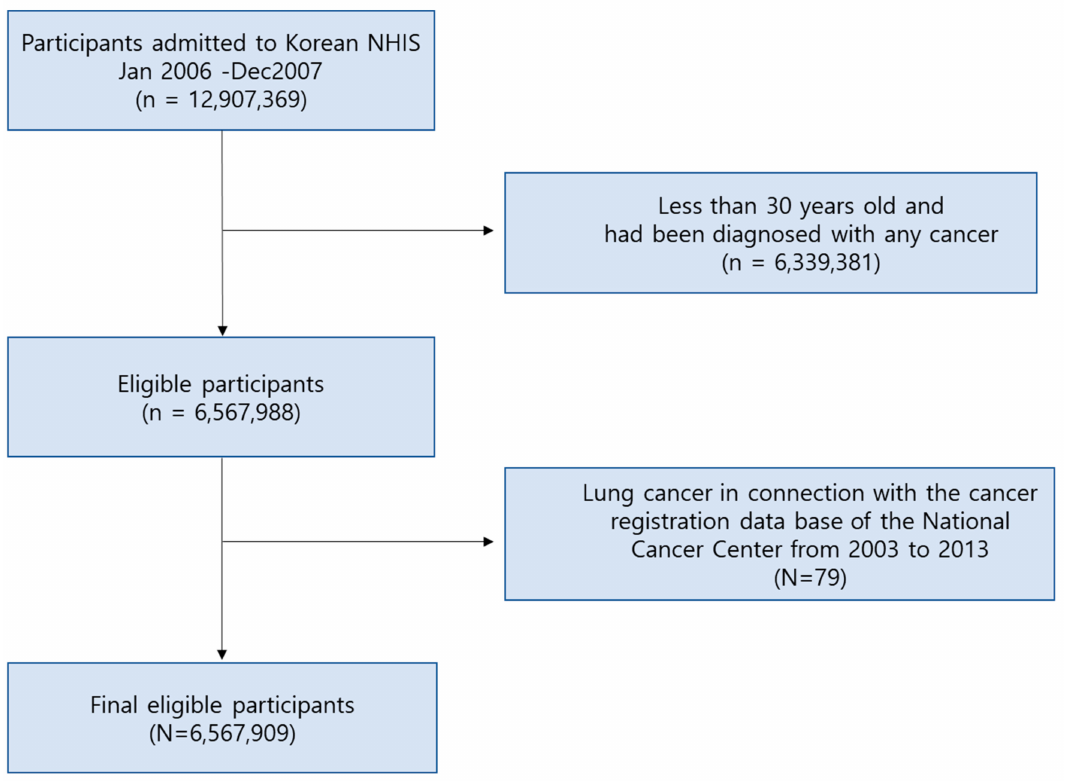
Figure 1. Flow chart of participants recruitment from Korean NHIS. NHIS = National Health Insurance